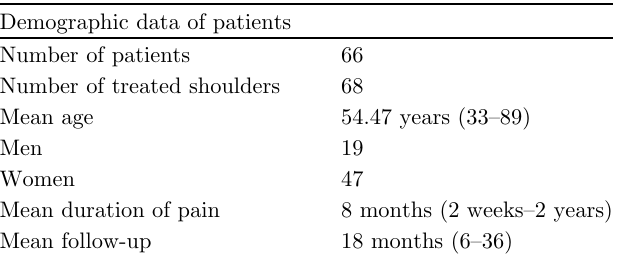
Table 1. Demographic data of the patients included in the study.